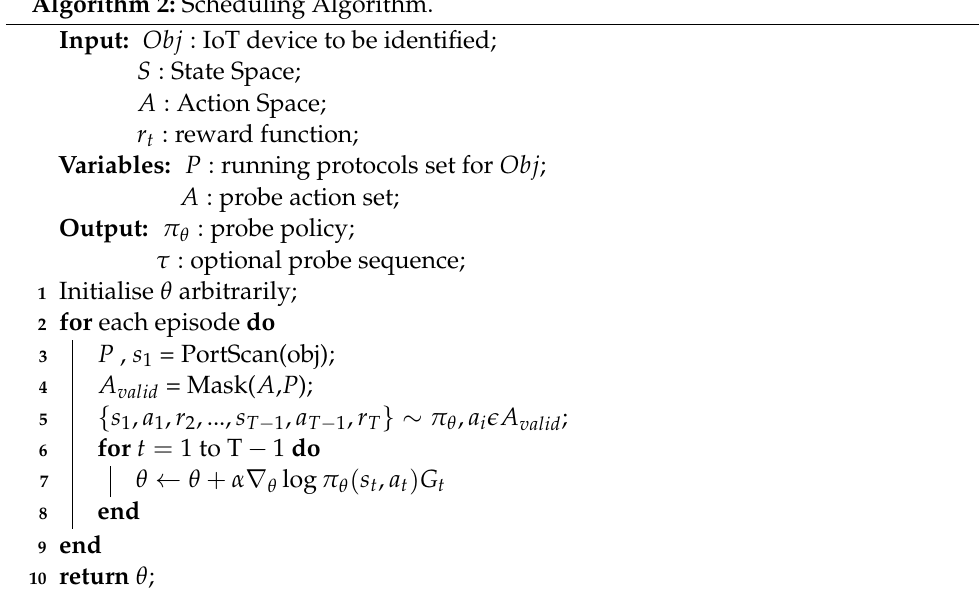
Algorithm 2: Scheduling